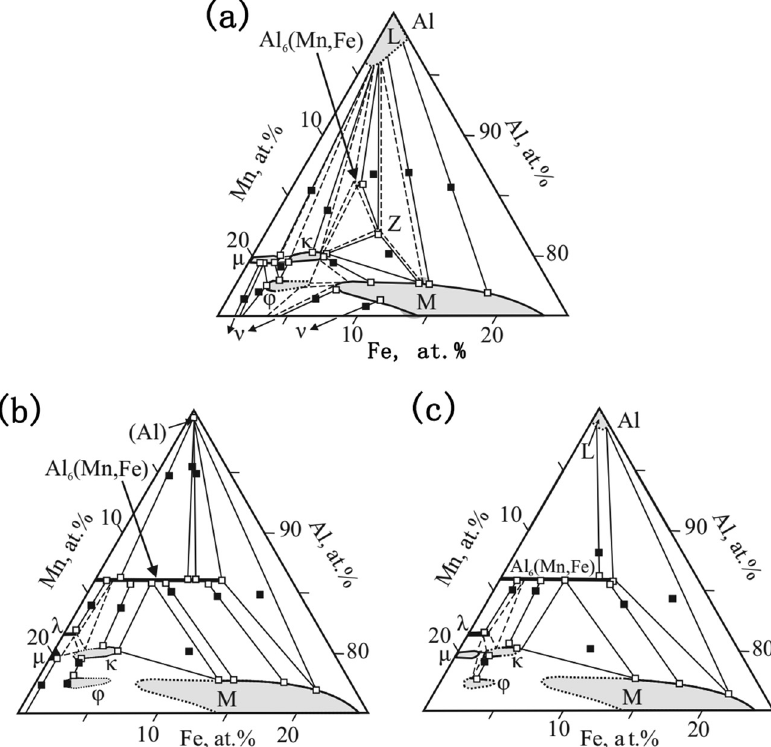
Figure 1: Partial isothermal section of Al – Mn – Fe alloy at 740°C ( a ) , 695°C ( b ) and 650°C ( c ) [ 20 ] . Reproduced by permission of